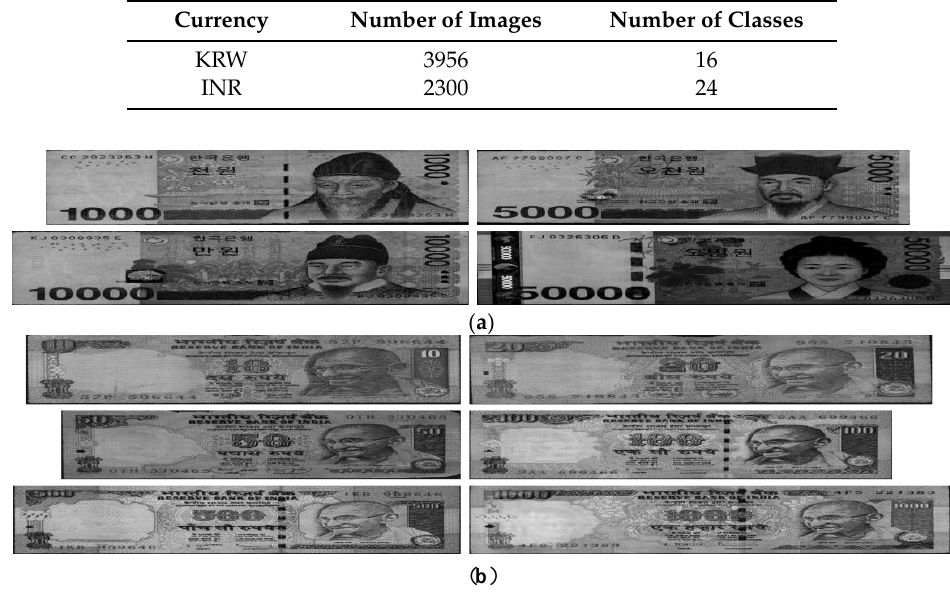
Figure 10. Examples of banknote images used in the experiment: ( a ) KRW; ( b ) INR. Table 8. Comparison of the EER in INR fitness classification between the proposed method and a previous method. (unit: %).